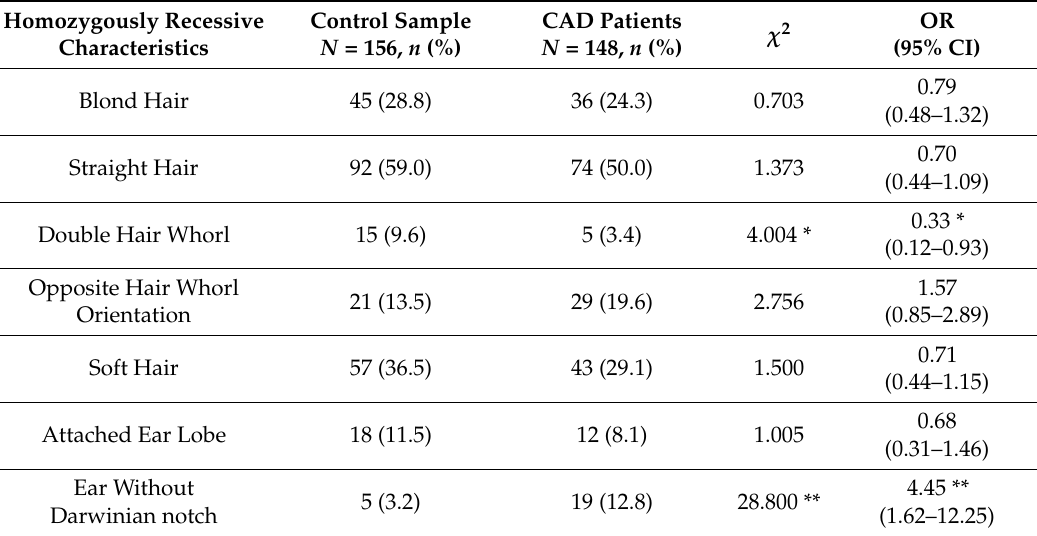
Table 2. Frequencies of homozygously-recessive characteristics among patients with CAD and individuals of the control